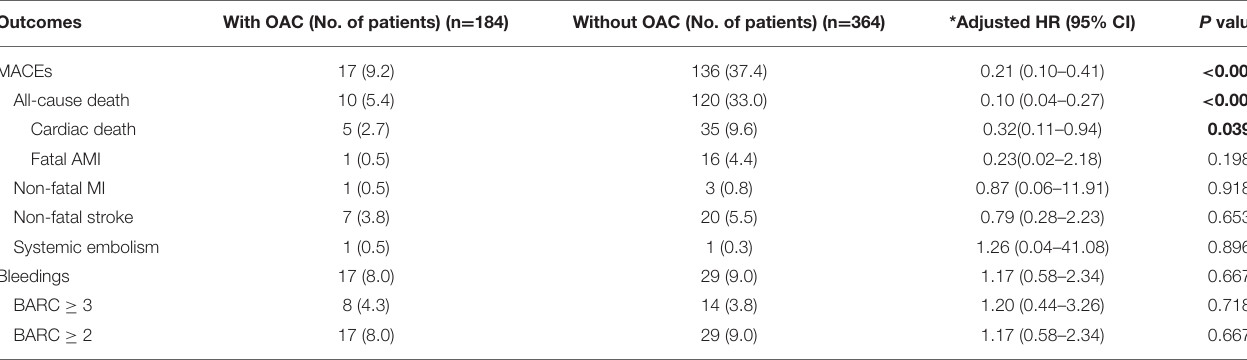
TABLE 2 | Risk of adverse clinical outcomes in patients with or without OAC. Outcomes With OAC (No. of patients) (n = 184)